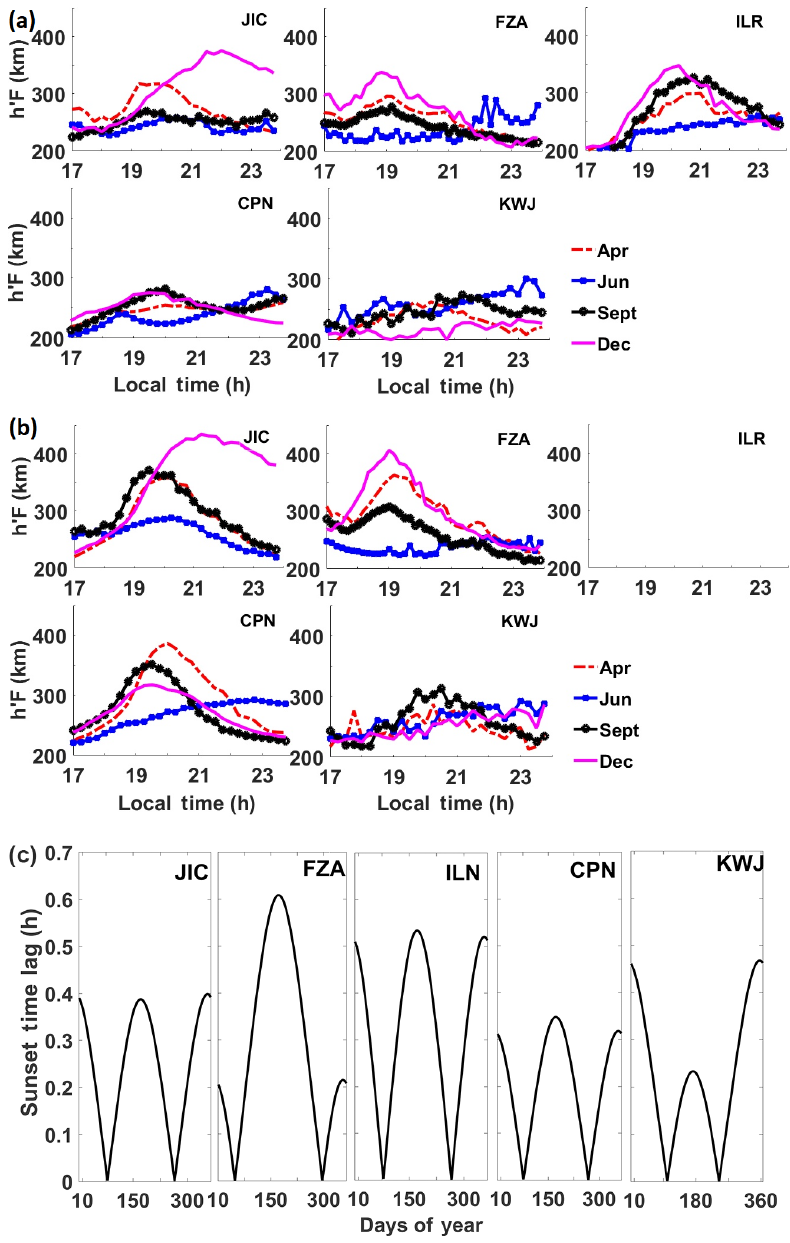
Figure 7. Monthly average of the virtual height during (a) MSA and (b) LSA. (c) The estimated sunset time lag between the geomagnetic conjugate points for each of the longitude